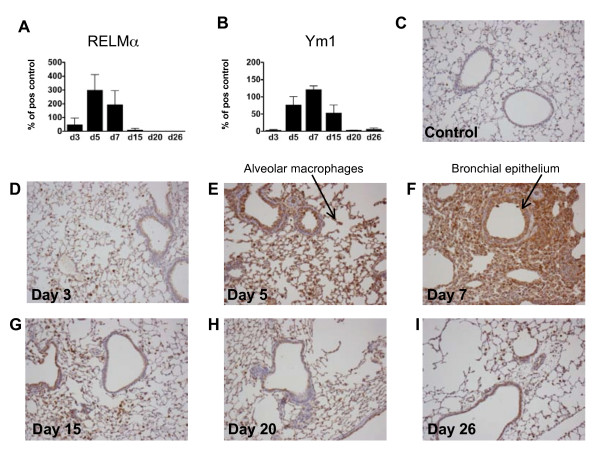
Time course of protein expression of ChaFFs in Nb infected lungs. Western blot analysis of lung lavages harvested at different time points post Nb infection (4 Nb mice per timepoint) suggested that the secretion of ChaFFs RELMα (A) and Ym1 (B) peaked around 5-7 days post infection. Data are expressed as percentage of a positive control sample (pooled lung lavages of three Nb-infected mice). Representative photomicrographs from Nb-infected lung tissue sections stained histologically for Ym1 at the indicated time points, plus an uninfected control lung (C), illustrate peak expression of brown Ym1 staining of epithelial cells and macrophages (E-F).